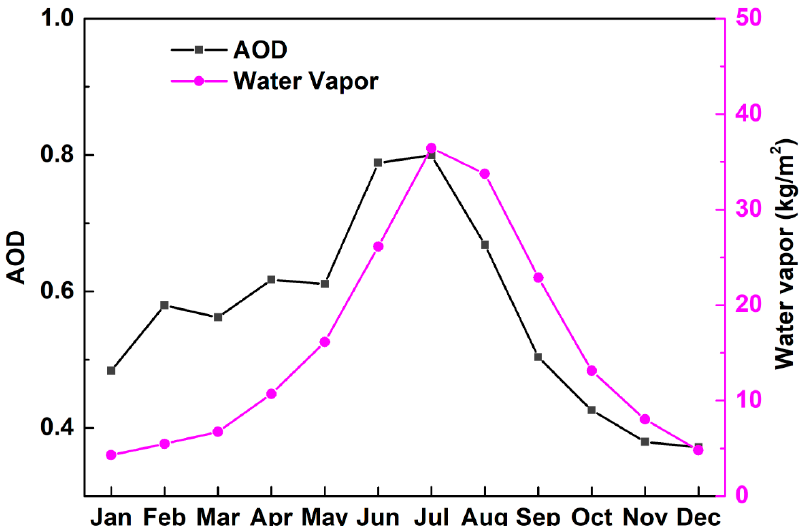
Figure 10. Monthly variations of aerosol optical depth (AOD) and water vapor in northern China during